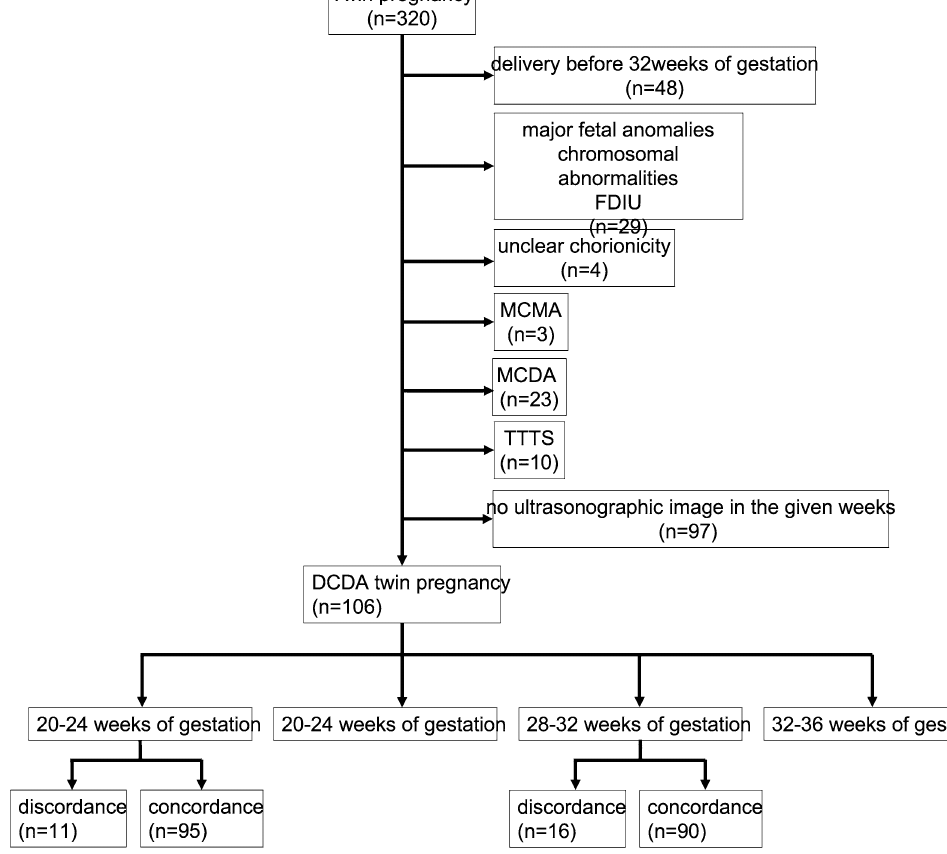
Figure 3. Flowchart for the review of studies. FDIU, fetal death in uterus; MCMA, monochorionic monoamniotic; MCDA, monochorionic diamniotic; TTTS, twin-to-twin transfusion syndrome; DCDA, dichorionic